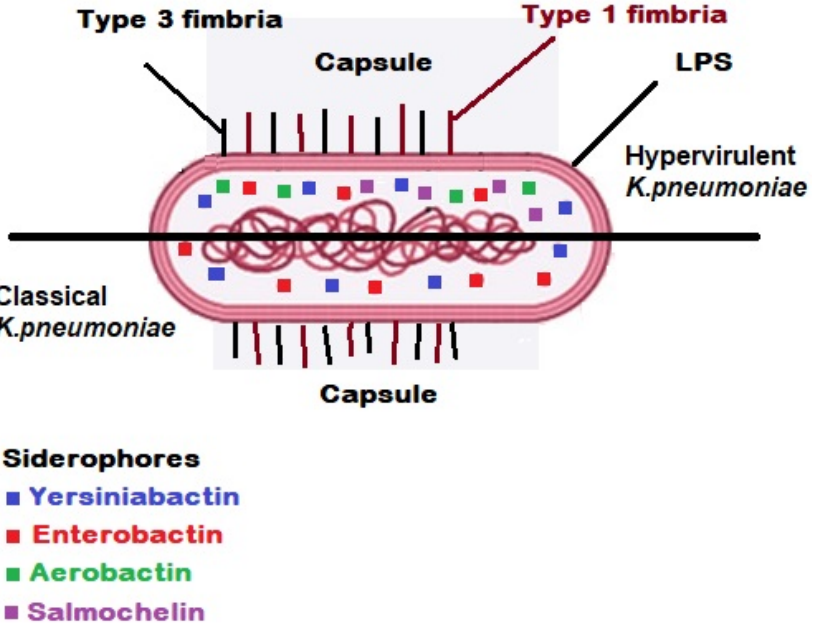
Figure 1. Virulence factors in classical/hypervirulent strains of K. pneumoniae [57]. Two types of fimbriae are involved in pathogenesis of the bacteria through attachment to the biotic (human host urothelium) and abiotic (urinary catheter) surfaces to start the process of colonisation, biofilm formation and bacterial invasion. The polysaccharide capsule in K. pneumoniae is known as a pivotal virulence factor which acts as the outermost layer in a bacterial cell and interacts with the host. Lipopolysaccharide (LPS) is an effective protective structure against serum complement proteins in parallel with the presence of capsule.